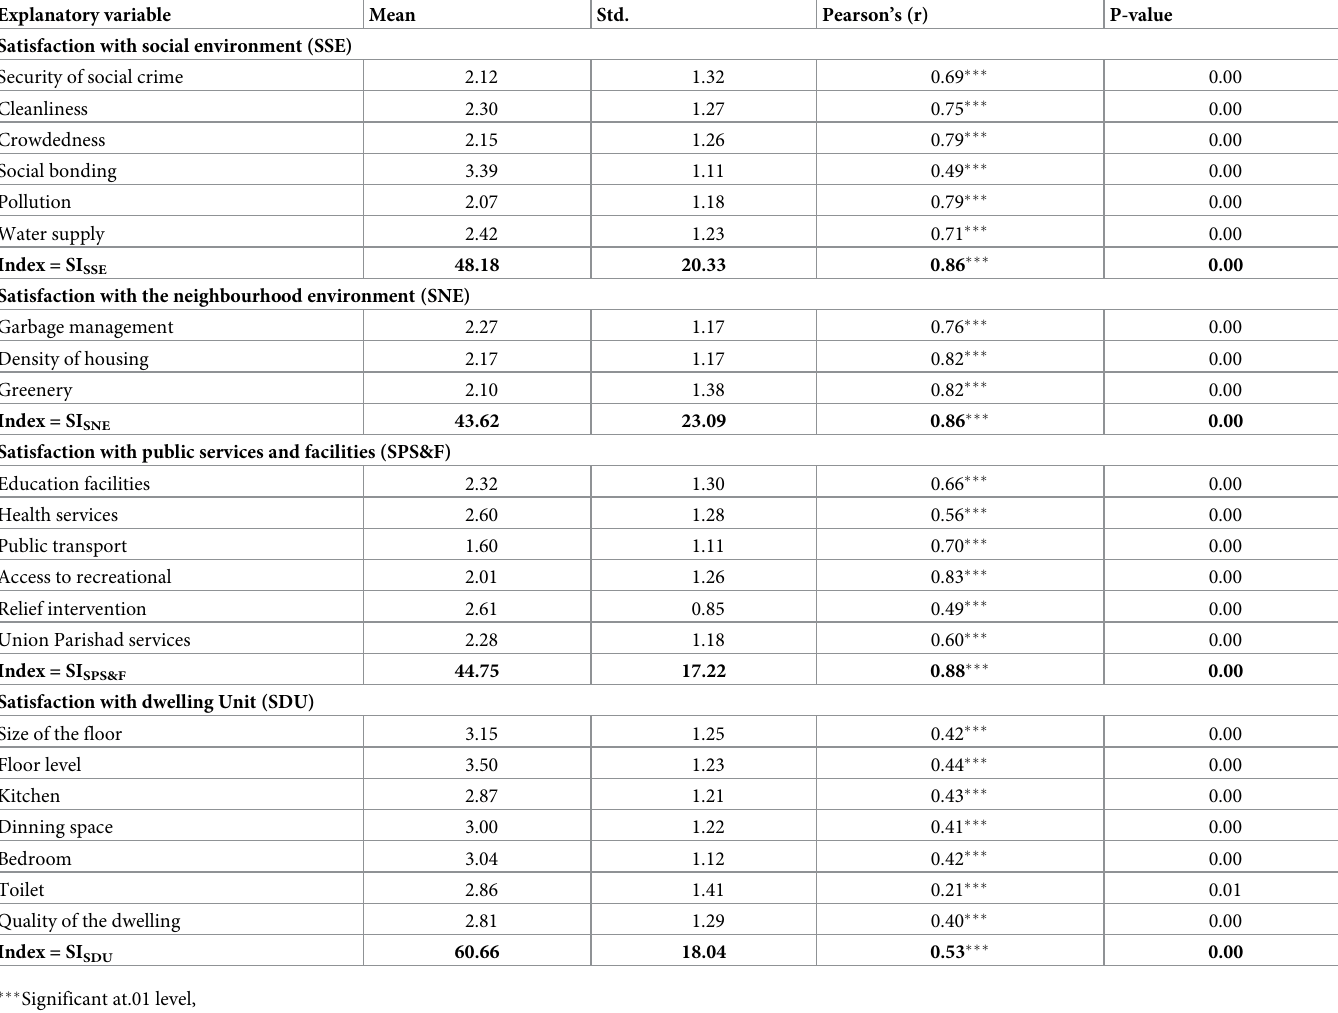
Table 7. Pearson correlation test between residential satisfaction and different